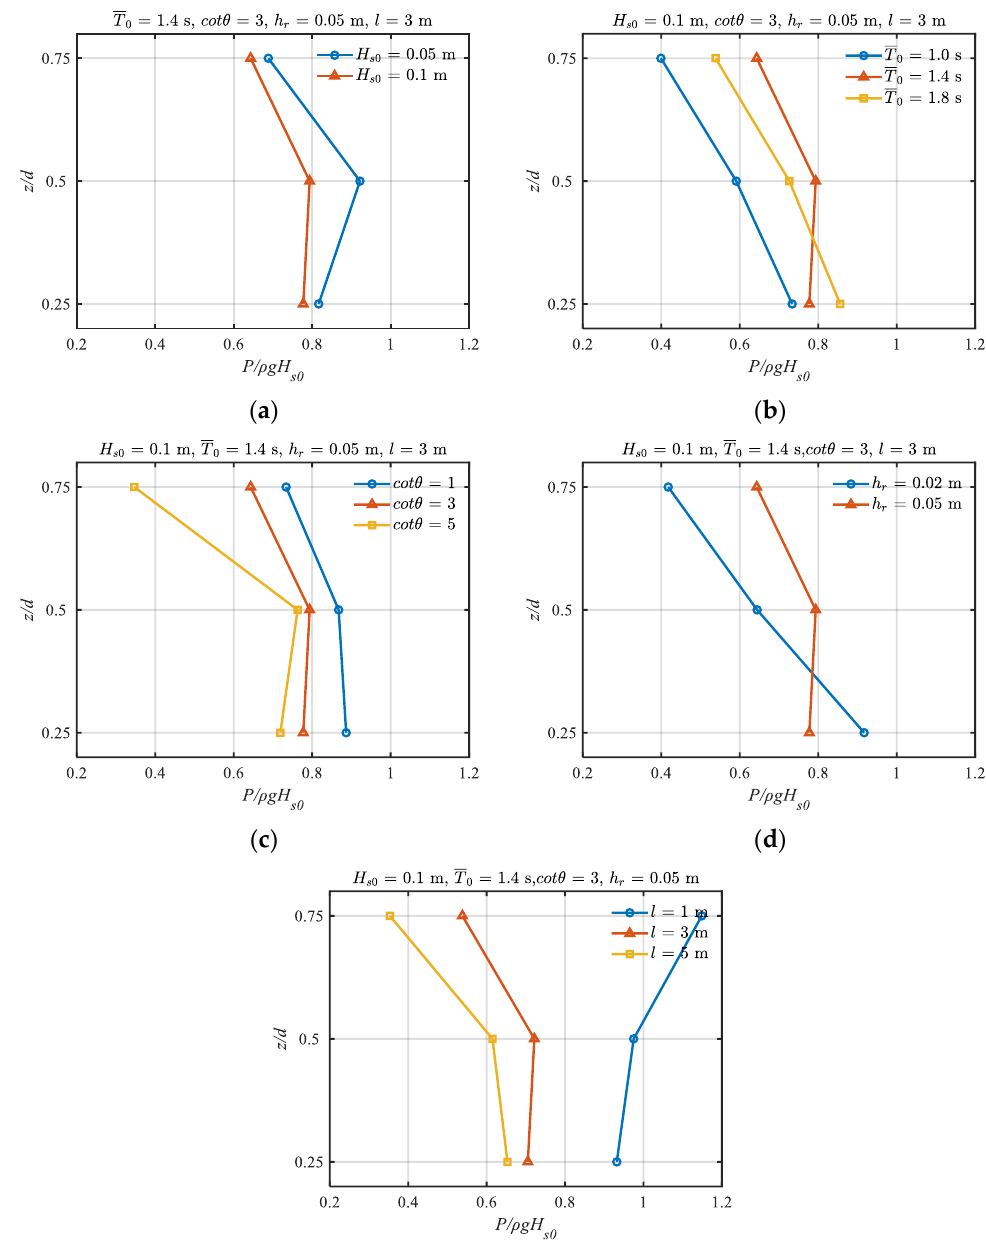
Figure 17. Irregular wave peak pressure distribution along the seaward surface of the vertical sea- wall for different cases: ( a ) H s 0 ; ( b ) 0 T ; ( c ) cot θ ; ( d ) h r ; ( e ) l . for different cases: ( a ) H s 0 ; ( b ) T 0 ; ( c ) cot θ ; ( d ) h r ; ( e ) l